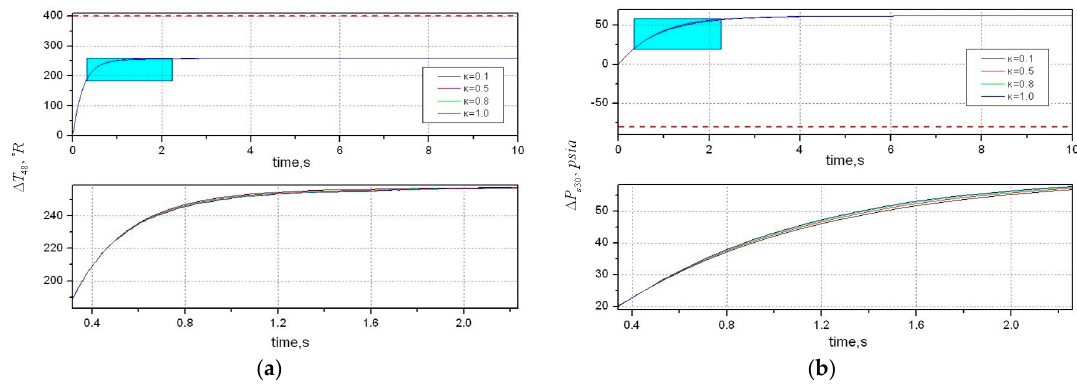
Figure 5. Limited output response with uncertainty in system parameters. ( a ) High-pressure turbine outlet temperature response; and ( b ) high-pressure compressor outlet static pressure response.